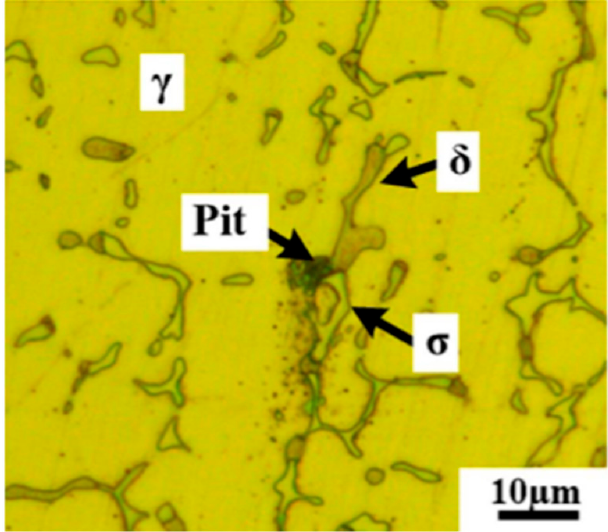
Figure 10. Pit nucleation at the interphase interface [68].